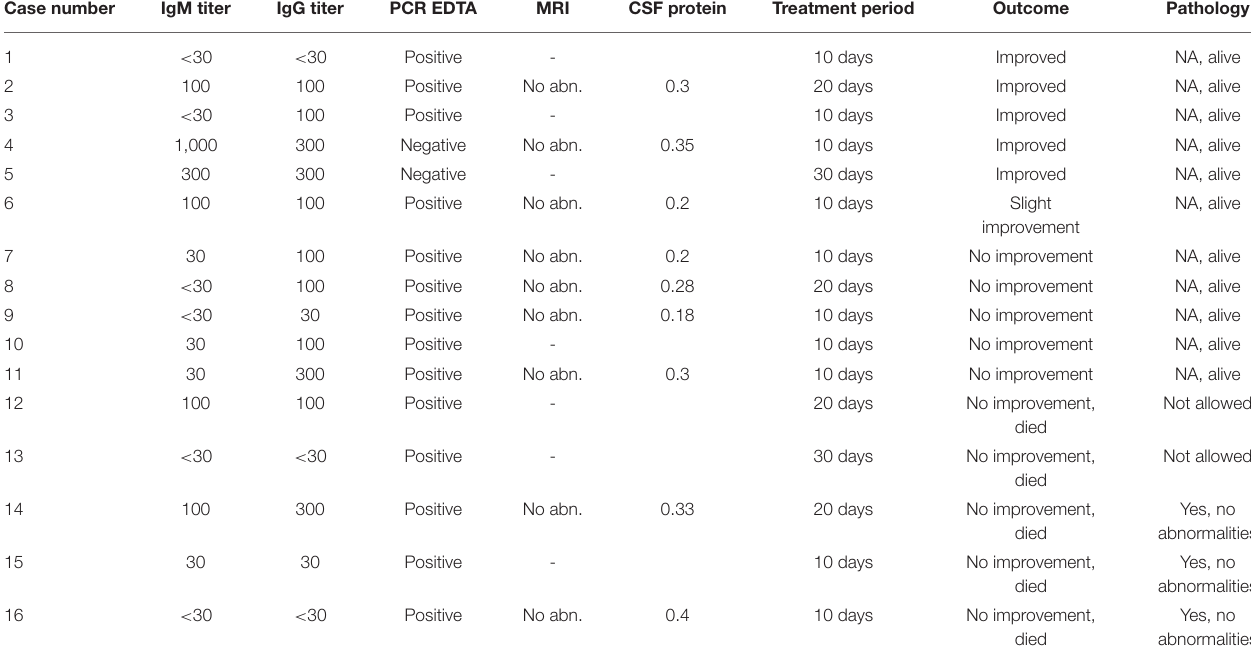
TABLE 2 | Laboratory and additional findings and outcomes. Case